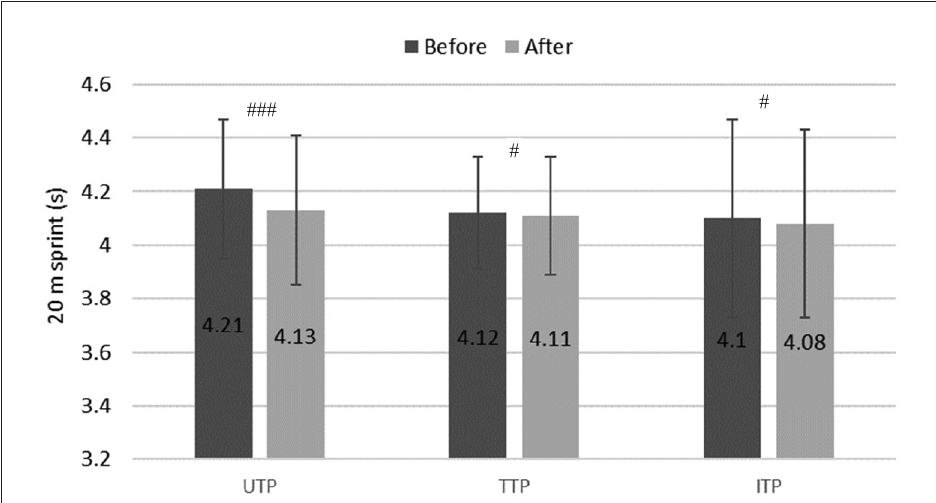
Figure 2. Indicators of 20 m sprint test (s) of mini-basketball